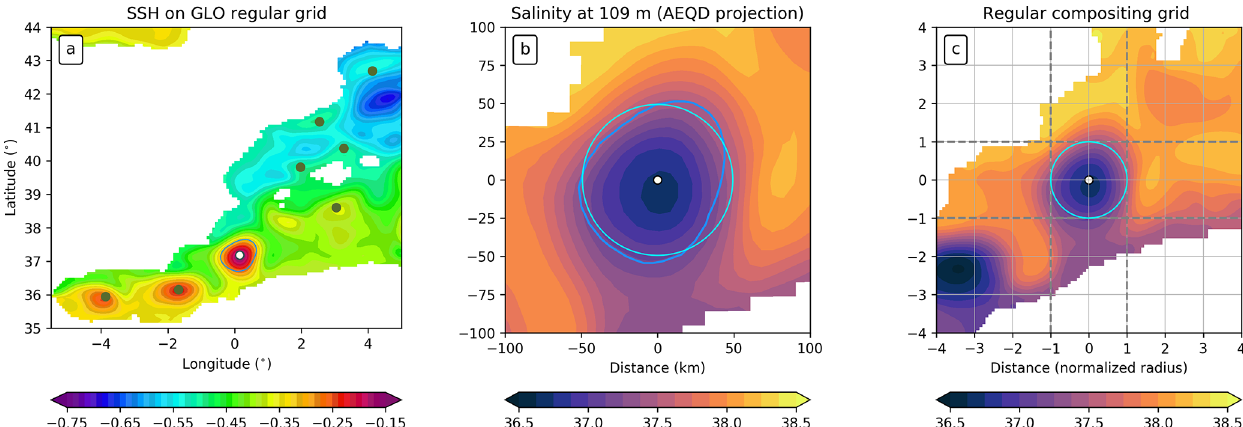
Figure 2. Illustration of the sequential compositing methodology using example SSH and salinity fields from GLO on 13 September 2013. (a) SSH is plotted on a regular grid over the western Mediterranean eddy-tracking domain. The most intense of several eddy-tracker-identified anticyclones is marked in white near 37 ◦ N, 0 ◦ E, and its corresponding speed-based contour is plotted in blue. Other identified eddies are marked in green. (b) A zoom over the intense GLO eddy of salinity at a depth of 109m (plotted on an azimuthal equidistant projection; AEQD) shows the fresh salinity anomaly associated with the eddy. The light blue circle corresponds to the eddy radius. (c) The salinity field interpolated from the AEQD grid to the eddy-centric grid. Gray dashed lines highlight the radial extent of the